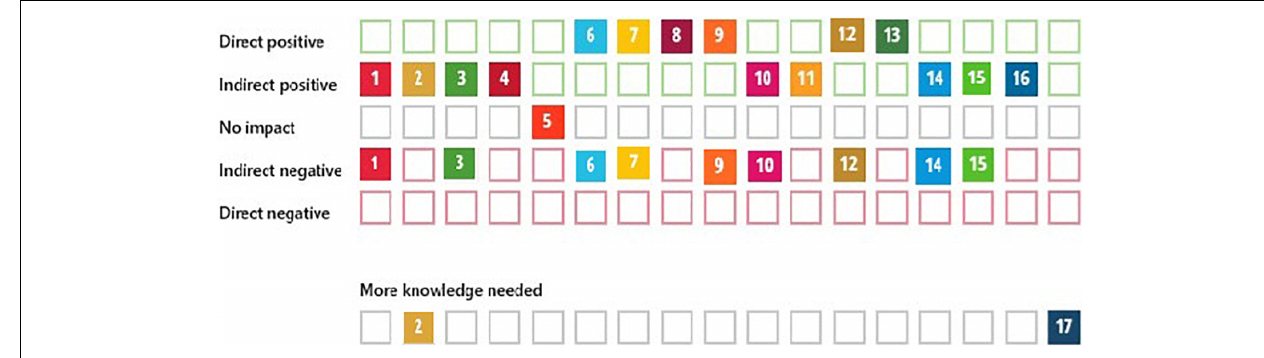
FIGURE 3 | Overview of CCU/SDG assessment. Source: Author, based on graphical representation of the SDG impact assessment